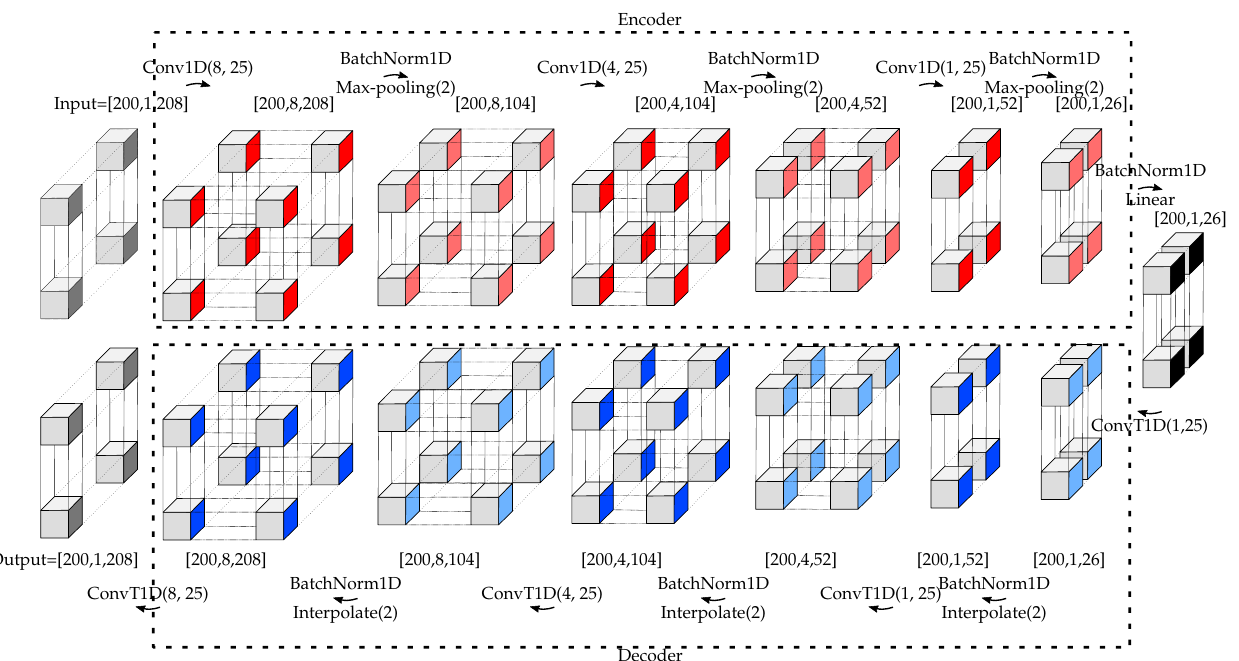
Figure 9. Structure of DCAE. The size of each tensor is depicted in the figure. This structure is used for the proposed decentralized approaches. In the case of centralized approaches, only the size of the input is changed (in the second dimension, 1 is replaced by R ).